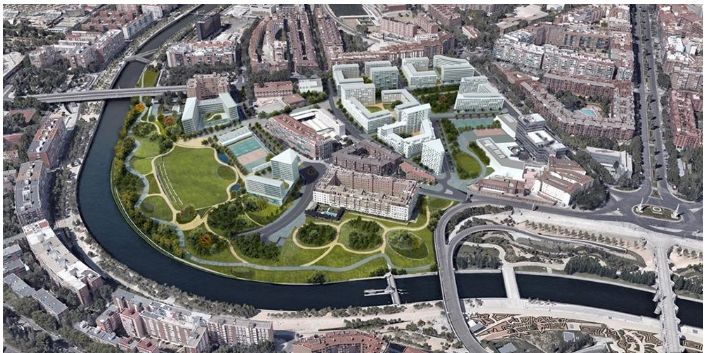
Figure 5. Buildings recreated in the Nuevo Mahou-Calderón proposal (2017) [47]. Copyright 2017 E.BARDAJI Y